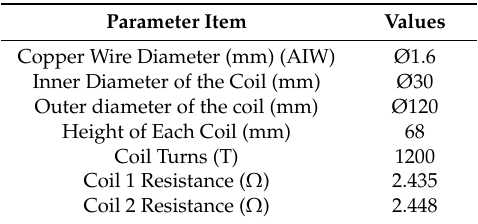
Figure 11. MR fluids actuated catheter haptic master system. 2.2. Robotic Catheter Navigation Slave System The Robotic catheter navigation slave system (RCNS) has two functions. One is to manipulate the catheter just like the surgeon catheter intervention, and another is to measure the interaction force during the catheter intervention surgery procedure. Therefore, in the slave system, the catheter manipulator is designed to actuate the patient catheter in transitional ways: To push, pull, and rotate, as shown in Figure 12. The grasper A is controlled by a direct current (DC) gear motor which is fixed on the platform of the linear stage to hold the catheter for axial and radial motions. When the platform moves to the front end, the grasper B (controlled by DC gear motor) will be clamped to keep the position of the catheter and grasper A will be released from the catheter. Then the platform moves back for the next catheter insertion motion. The kinematics of the catheter insertion and retraction process are shown in Figure 12. To prevent the slipping of the catheter, the generated axial gripping force of two graspers is 4 N, and the radial gripping torque of grasper A is 6 Nm, which meets the maximum value of force and torque applied by a surgeon during conventional interventional surgery [32]. Two stepping motors (ASM46AA, Oriental Motor Crop., Tokyo, Japan) with built-in rotor- position sensors are the source of actuation in radial and axial directions, respectively. The high- performance, micro-stepping driver (EN50178, Oriental Motor Crop., Tokyo, Japan) system provides no missteps, even when the load changes suddenly. Load cell (TU-UJ, TEAC Crop., Tokyo, Japan) is applied in this system to measure the axial force information at the distal end of the catheter. The mechanical structure of the force measurement is shown in Figure 8. The accuracy of the axial motion is 0.23 mm (for a 1 m catheter) and the rotation motion is 1.2 deg (for 360 deg) [33].